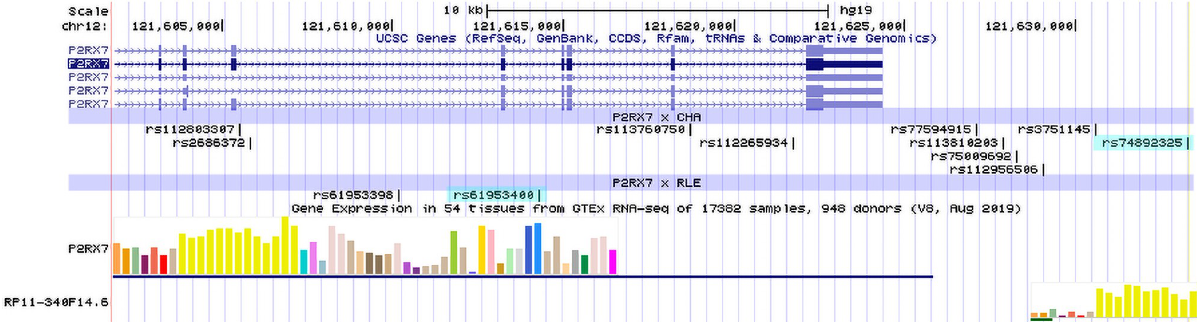
Fig 4. Genomic location of significant SNPs identified in the clumping procedure. Significant SNPs identified in the analysis with an effect on current depression symptoms in interaction with childhood adversities are denoted as P2RX7 x CHA; significant SNPs identified in the analysis with an effect on current depression symptoms in interaction with recent life event are denoted as P2RX7 x RLE; top SNPs in the two analyses are marked with light blue. In the gene expression part of the image, yellow bars indicate expression in nervous tissues. UCSC Genome Browser on Human Feb. 2009 (GRCh37/hg19) was used to visualize the location of polymorphisms on P2RX7 gene.